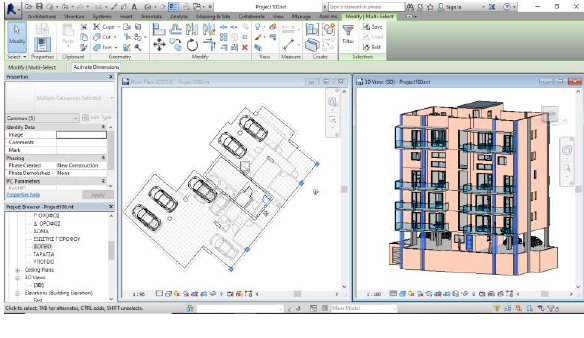
Figure 1. BIM model, LOD4 Source: Result of processing in Revit